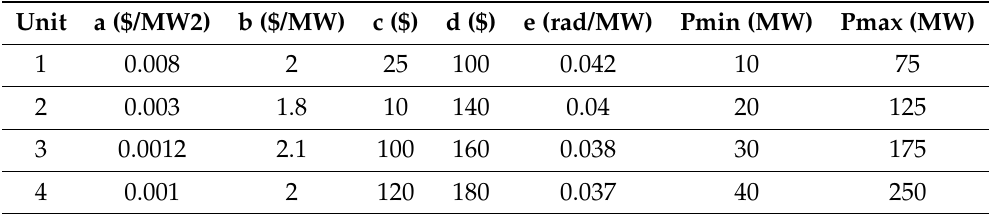
Table A7. Electrical Energy Generator unit data for Case Study